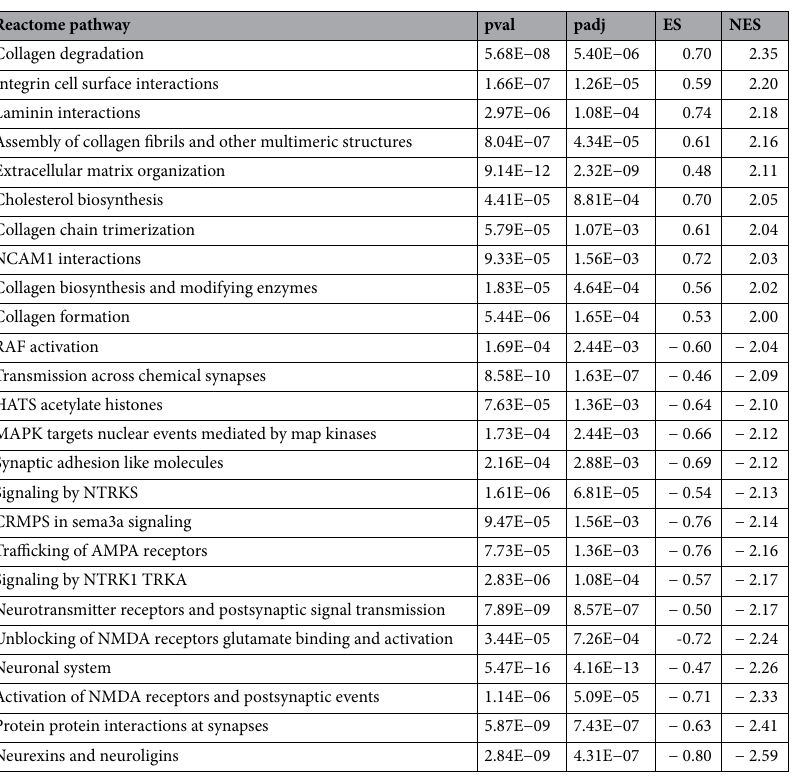
Table 1. Reactome pathways with NES > 2 or < − 2. pval enrichment p-value, padj Benjamini-Hochberg- adjusted p-value, ES enrichment score, NES normalized ES (ES divided by the mean ES from 1000 random